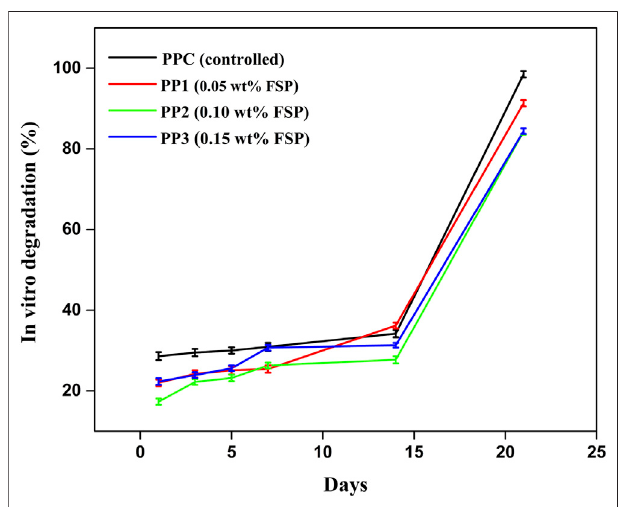
FIGURE 4 | In-vitro degradation analysis of PP hydrogels in PBS (pH